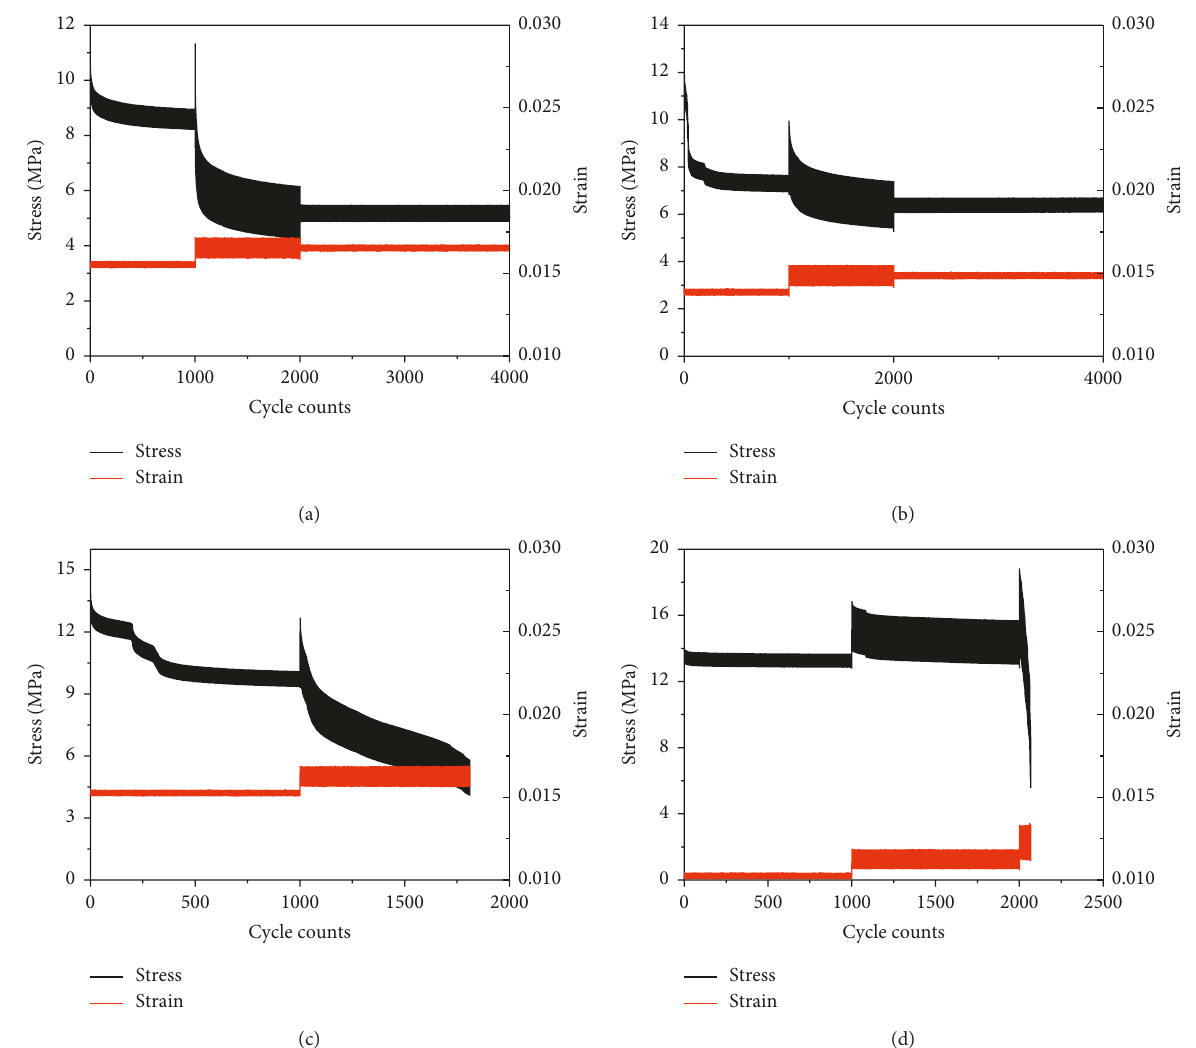
Figure 8: Diagram of stress-strain relationship under different loading paths. (a, b) Disturbance from 0.5‰ to 1‰ and then to 0.5‰. (c, d) Disturbance from 0.5‰ to 1‰ and then to